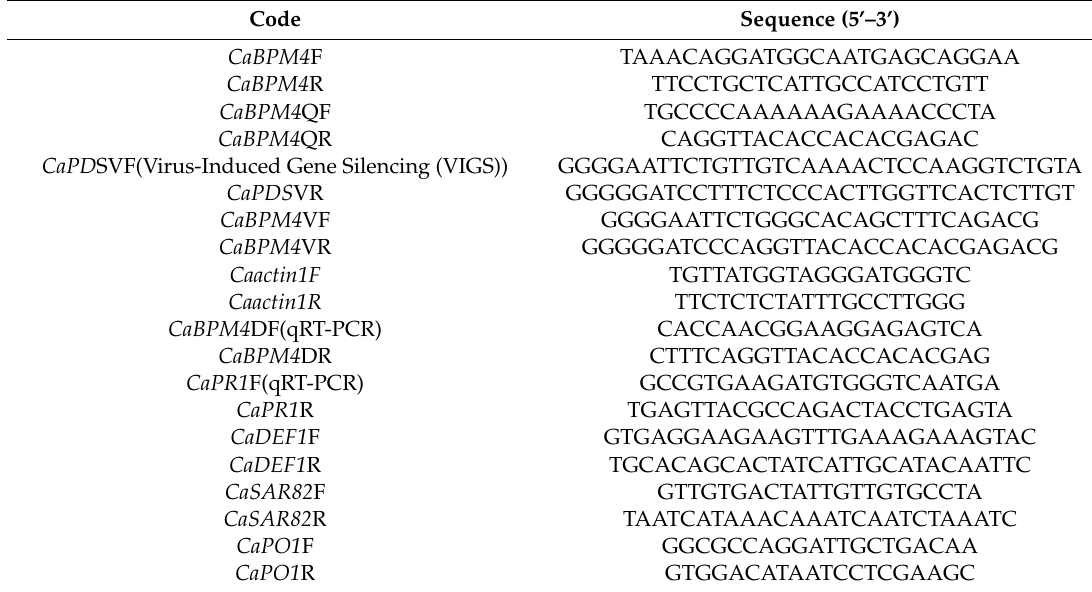
Table 1. Primer sequences used in the